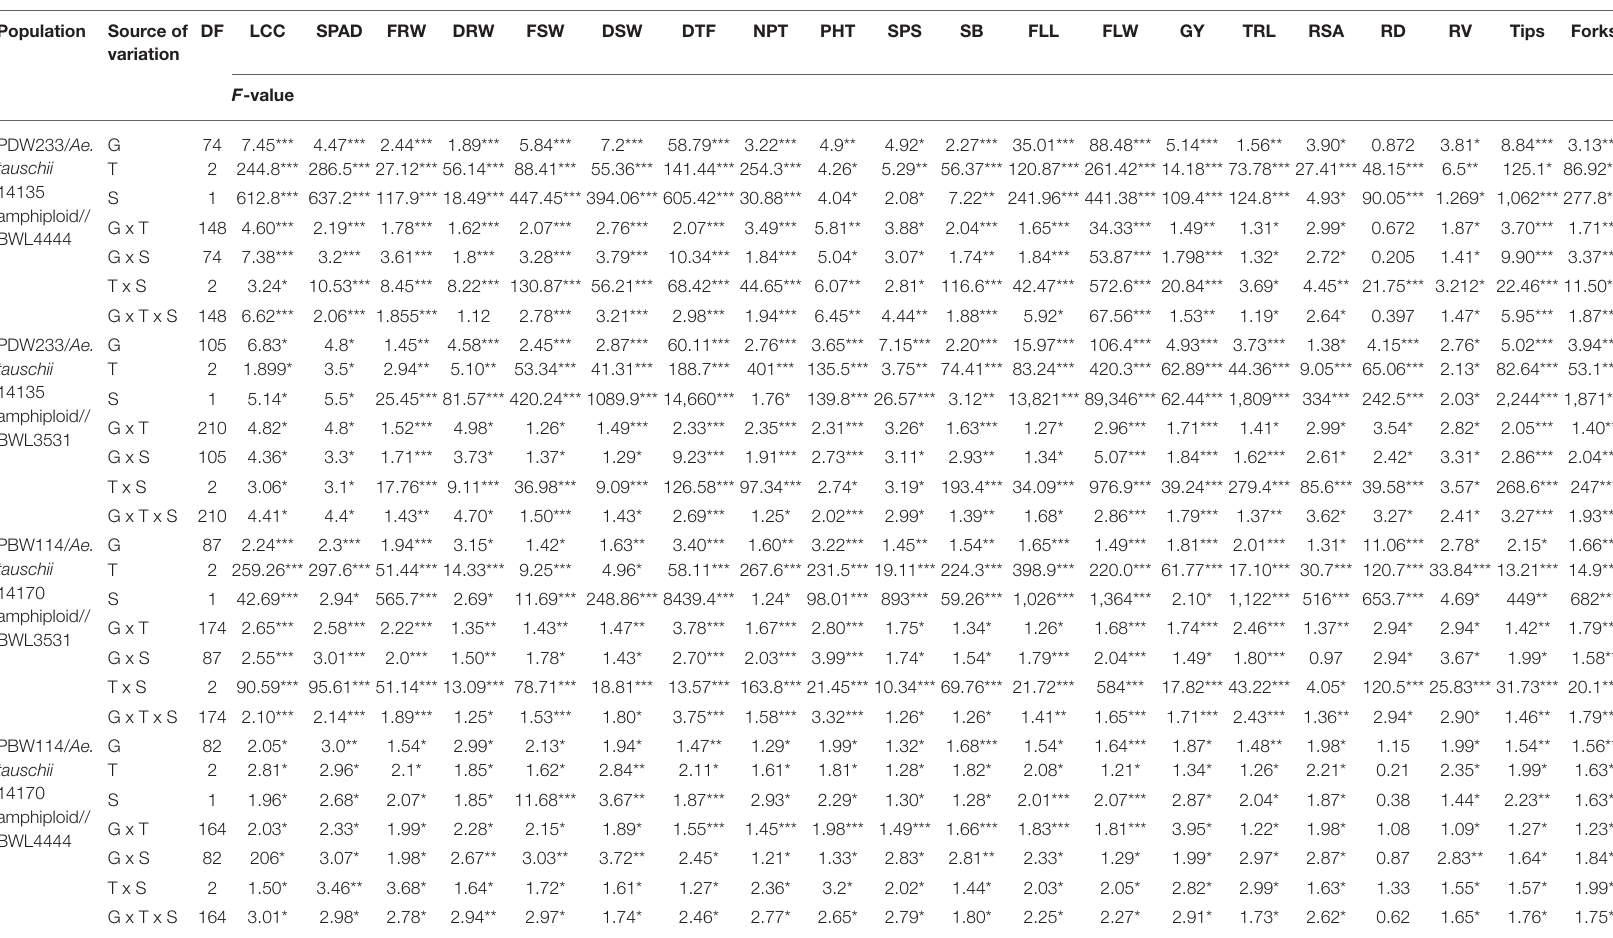
TABLE 2 | Analysis of variance (ANOVA) for the NUE-related, root, plant morphological, yield, and yield-related traits among genotype (G), treatments (T), seasons (S), and their interactions (G x T, genotype x treatment; G x S, genotype x season; T x S, treatment x season; and G x T x S, genotype x treatment x season). Population Source of variation